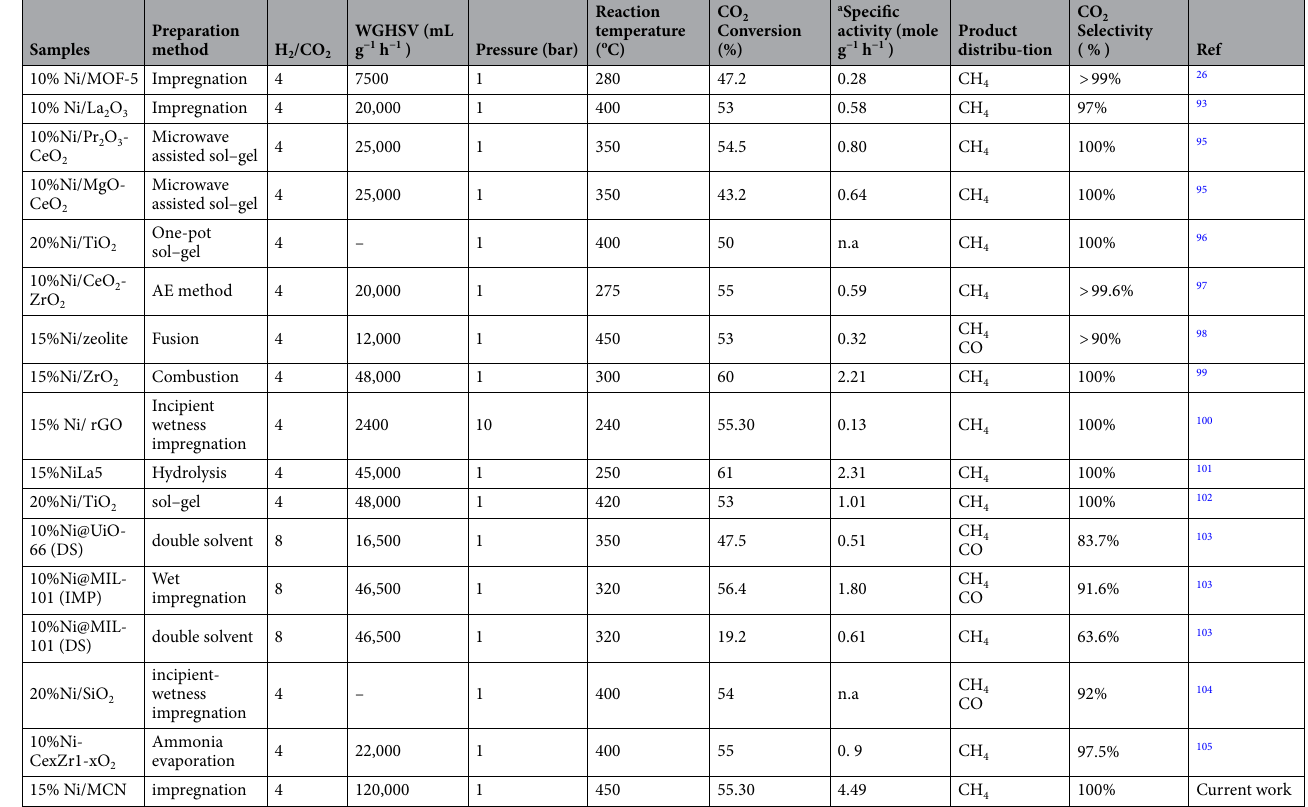
Table 4. Monometallic Ni-based catalysts for CO 2 methanation. a Specific activity normalized by the weight of the catalyst ( mole of CO 2 /( gram of catalyst* time